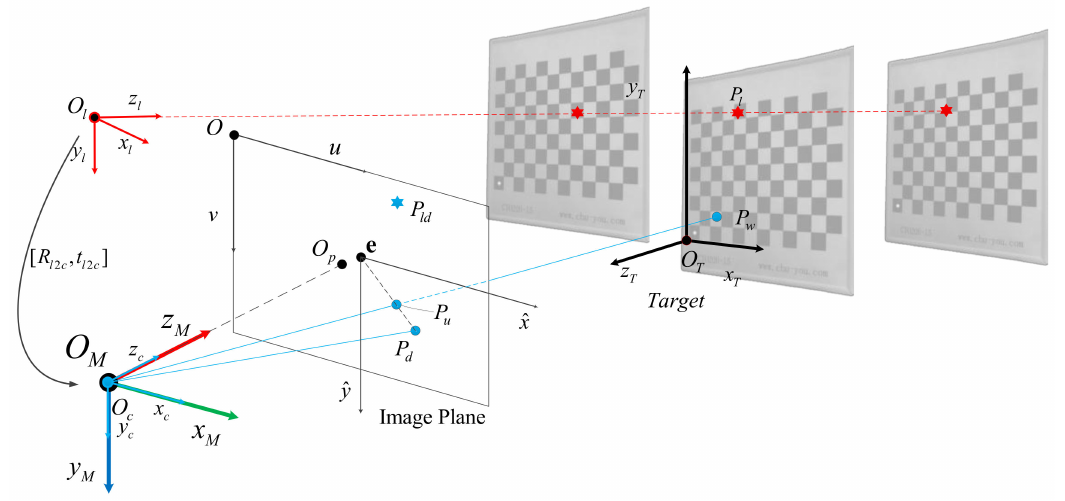
Figure 2. Changing of the azimuth and angle of the calibration plate and performing multiple